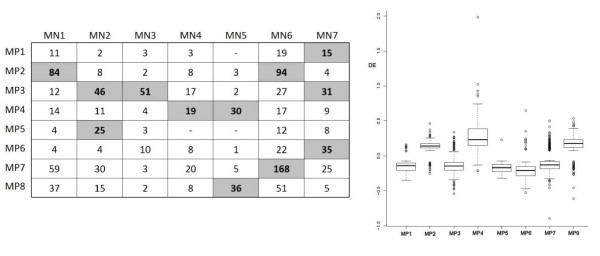
Left: Fisher’s exact test in modules superposition where coloured cells represents p-value <0.05; Right: CoP modules differential expression (DE).